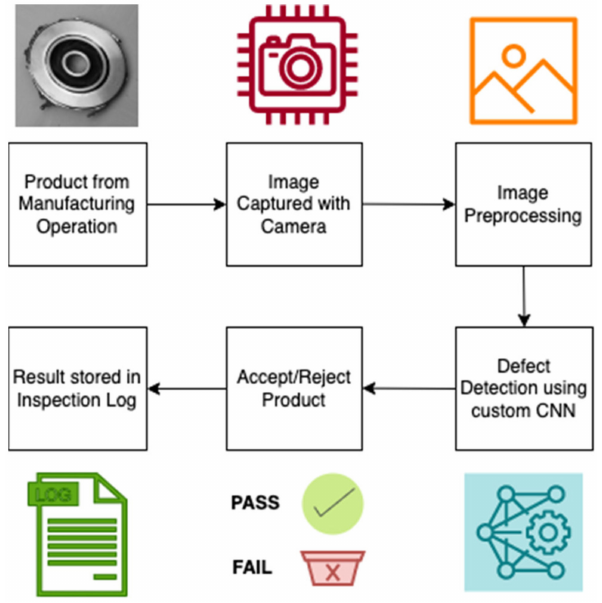
Figure 3. Artificial Intelligence based Smart Quality Inspection Methodology.